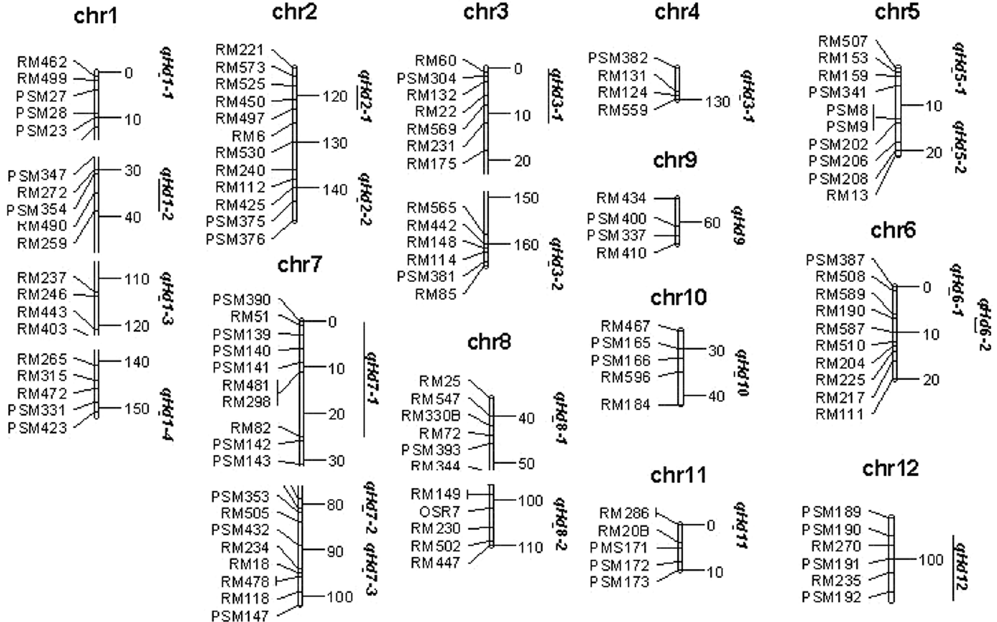
Figure 1. Distributions of QTLs positioned on heading date by the software of mrMLM.GUI on chromosomes (chr). Chr was the abbreviation of chromosome. Markers and genetic positions (cM) appeared at the left and the right of chromosomes, respectively. Points or vertical lines at the right of chromosomes represented QTLs.